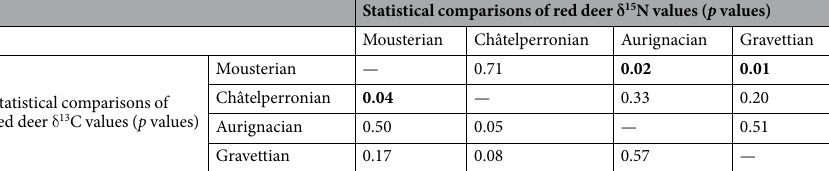
Table 6. Statistical test results comparing red deer δ 15 N and δ 13 C values within each cultural period. Statistically significant p values are highlighted in bold.